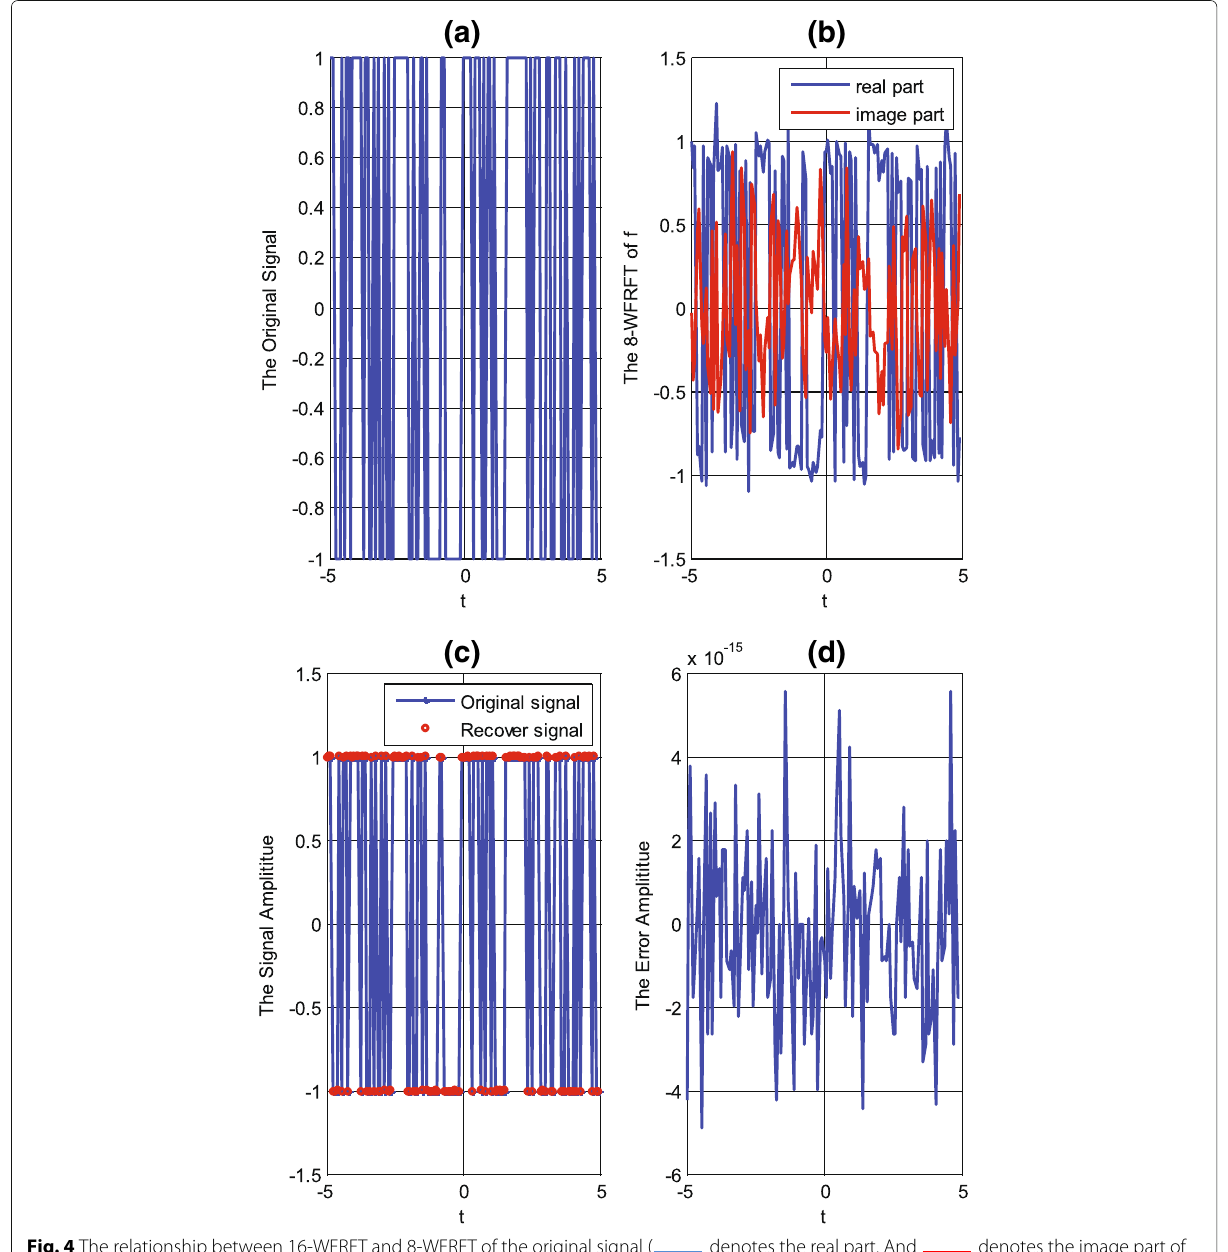
Fig. 4 The relationship between 16-WFRFT and 8-WFRFT of the original signal ( denotes the real part. And denotes the image part of 16-WFRFT signal. Moreover, is the original signal and is the recover